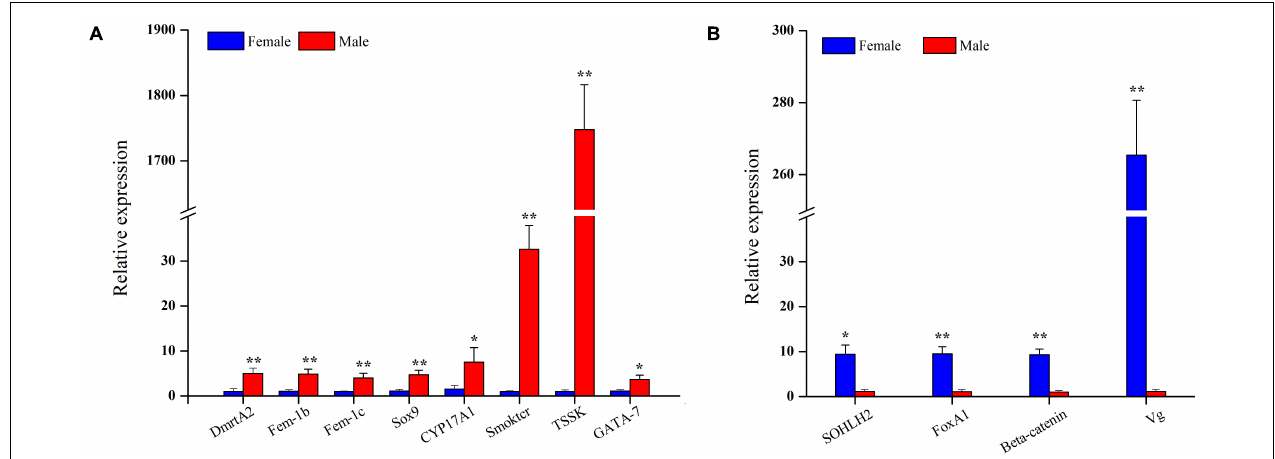
FIGURE 6 | Relative expression level of male-biased genes (A) and female-biased genes (B) between female and male gonads in S. constricta ( n = 4). Significant differences between female and male gonads are indicated with an asterisk for P < 0.05, and with two asterisks for P < 0.01.